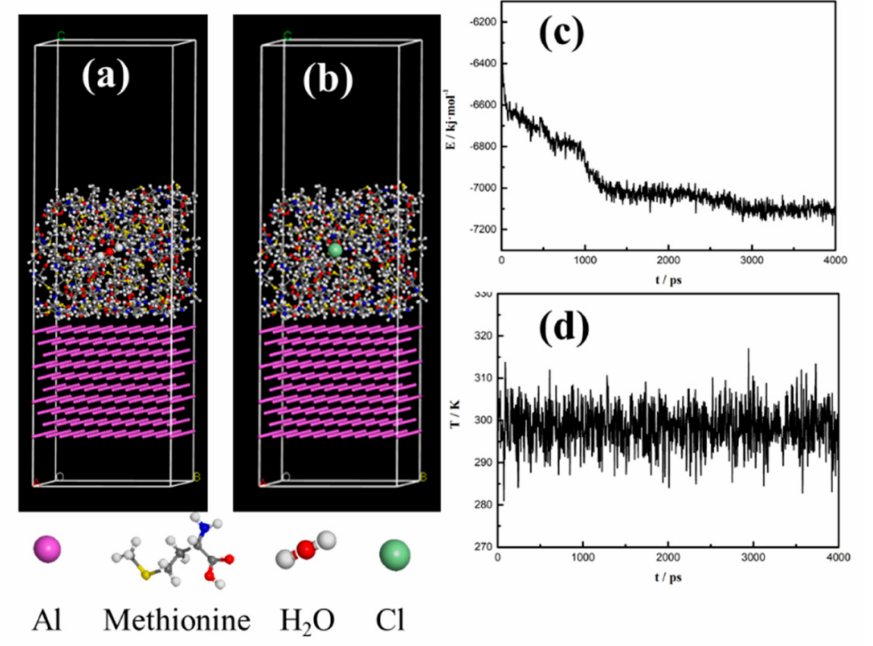
Figure 7. Models of H 2 O ( a ) and Cl − ( b ) diffusion in corrosion inhibitor membrane Met and temperature ( c ) and total energy ( d ) fluctuation curves of H 2 O diffusion in Met